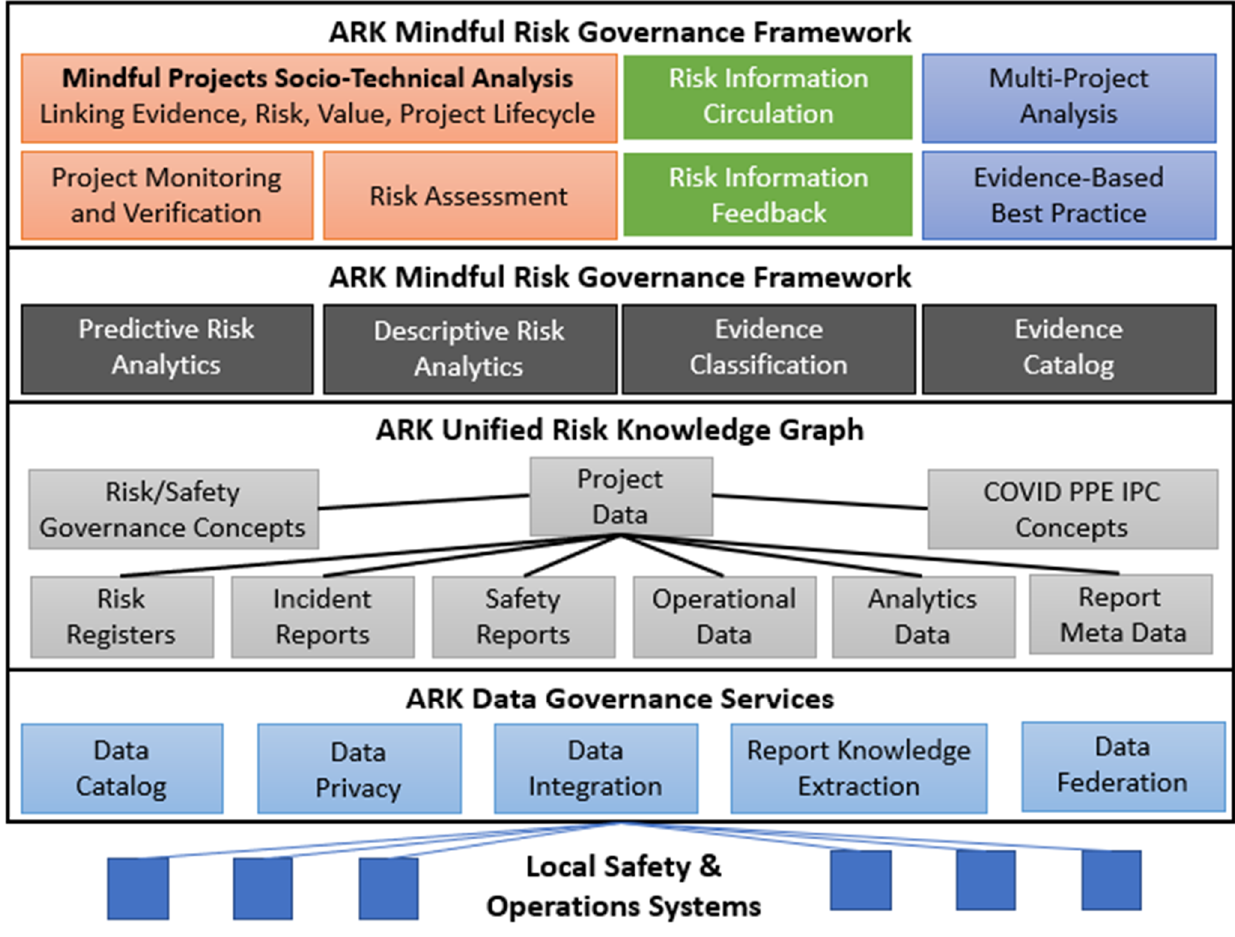
Figure 4. ARK Platform Mindful Risk Governance Framework.